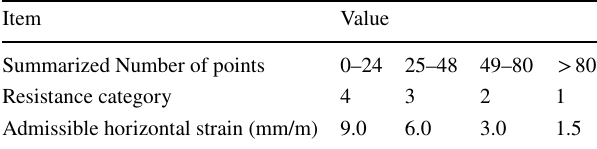
Table 3 Final the resistance of a given object (Mendec et al.